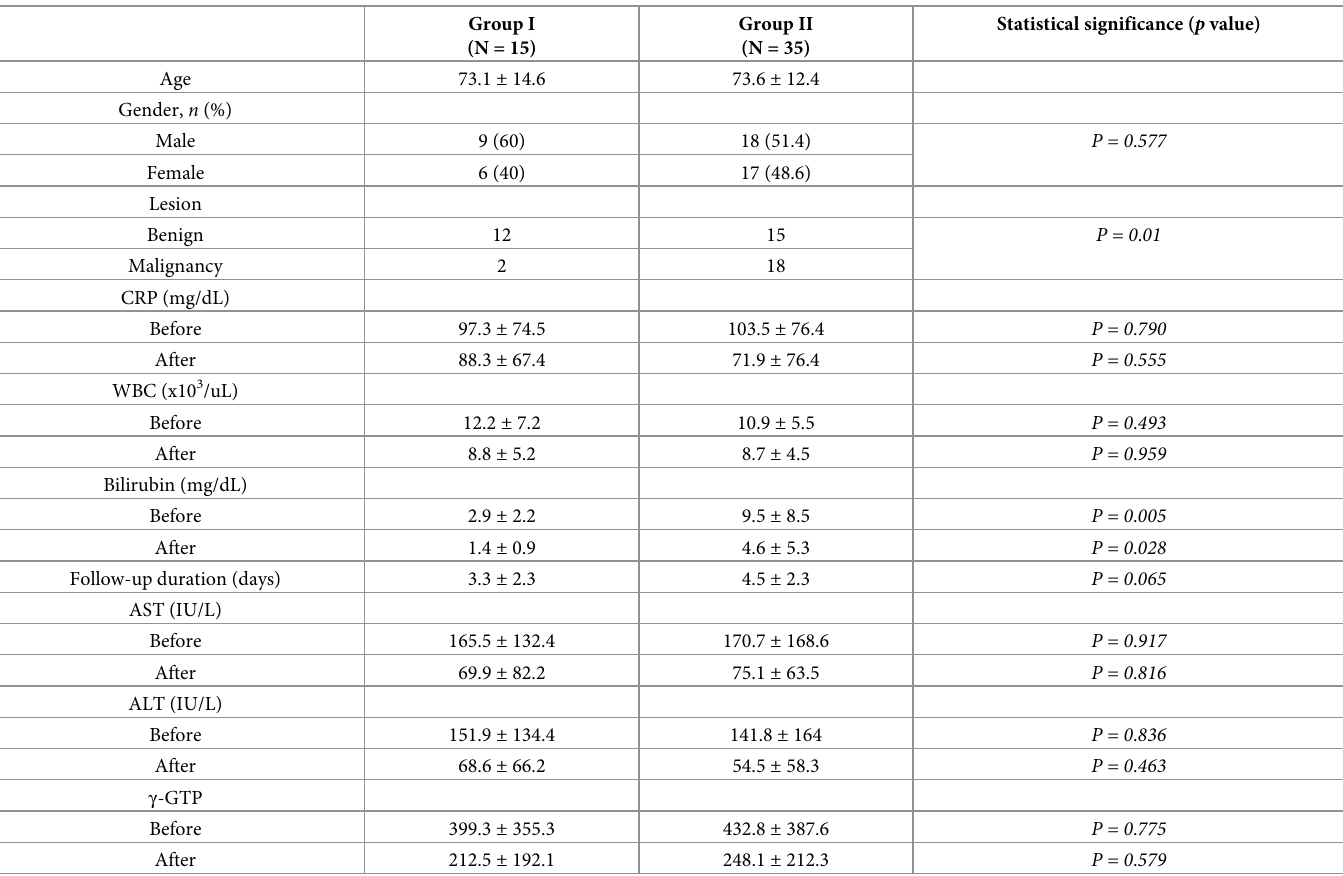
Table 2. Laboratory values before and after procedure and demographics in groups I and